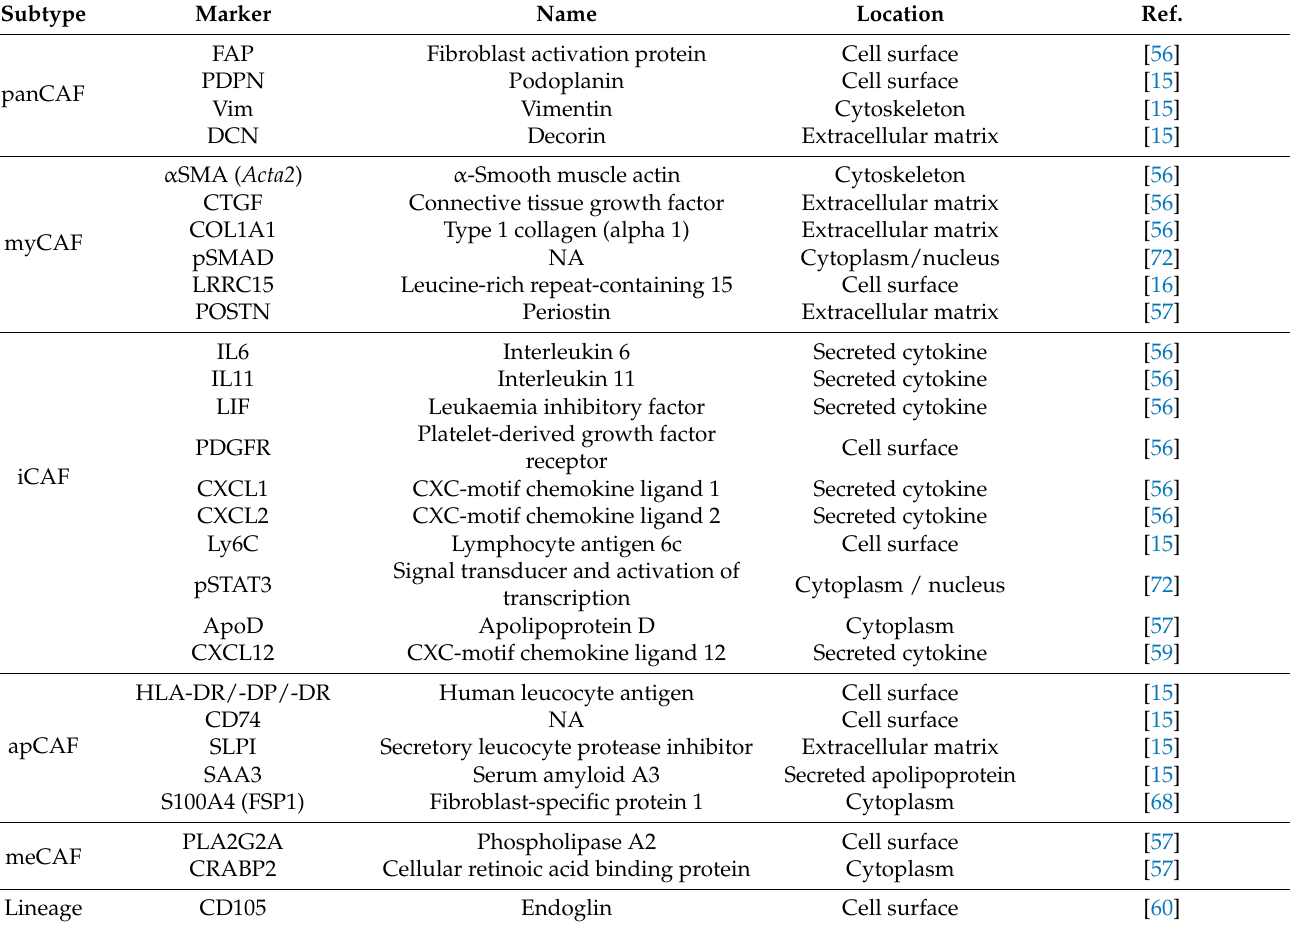
Table 1. CAF subtypes with their associated markers and